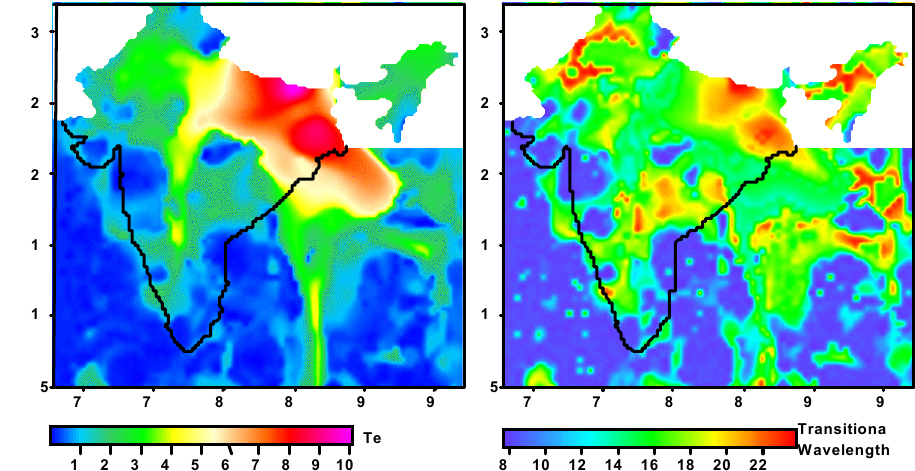
Figure 3. (a) Te map of the Indian shield and the adjoining oceanic regions. (b) Transitional wavelength (km).